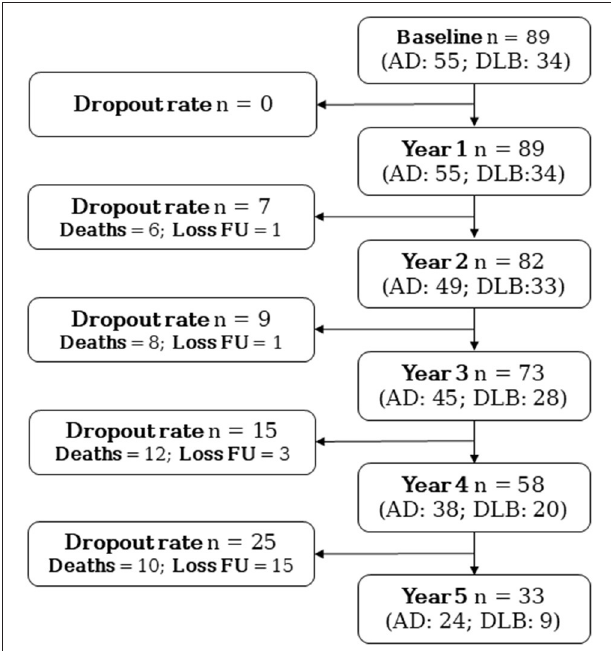
FIGURE 1 | Flowchart of patients at each time point of the study including dropouts. AD, Alzheimer’s disease; DLB, Dementia with Lewy bodies; Loss FU, Loss to